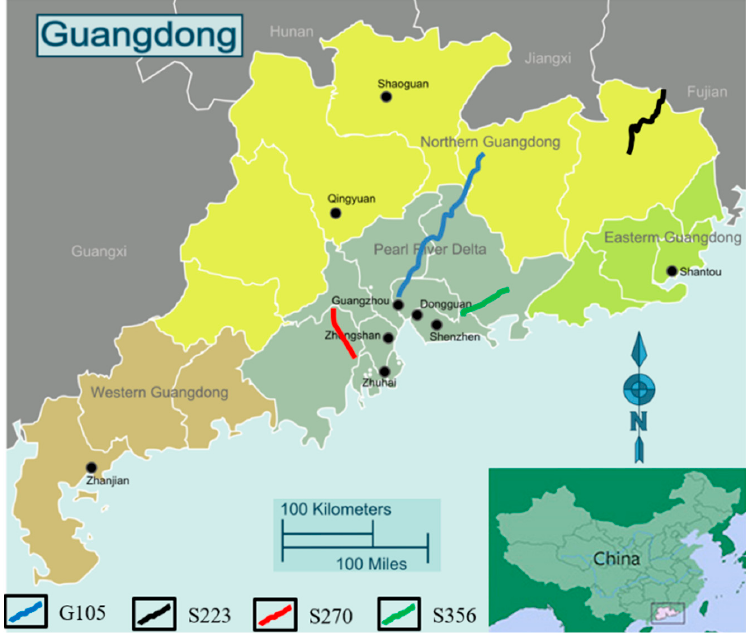
Figure 1. Location of the test highways.